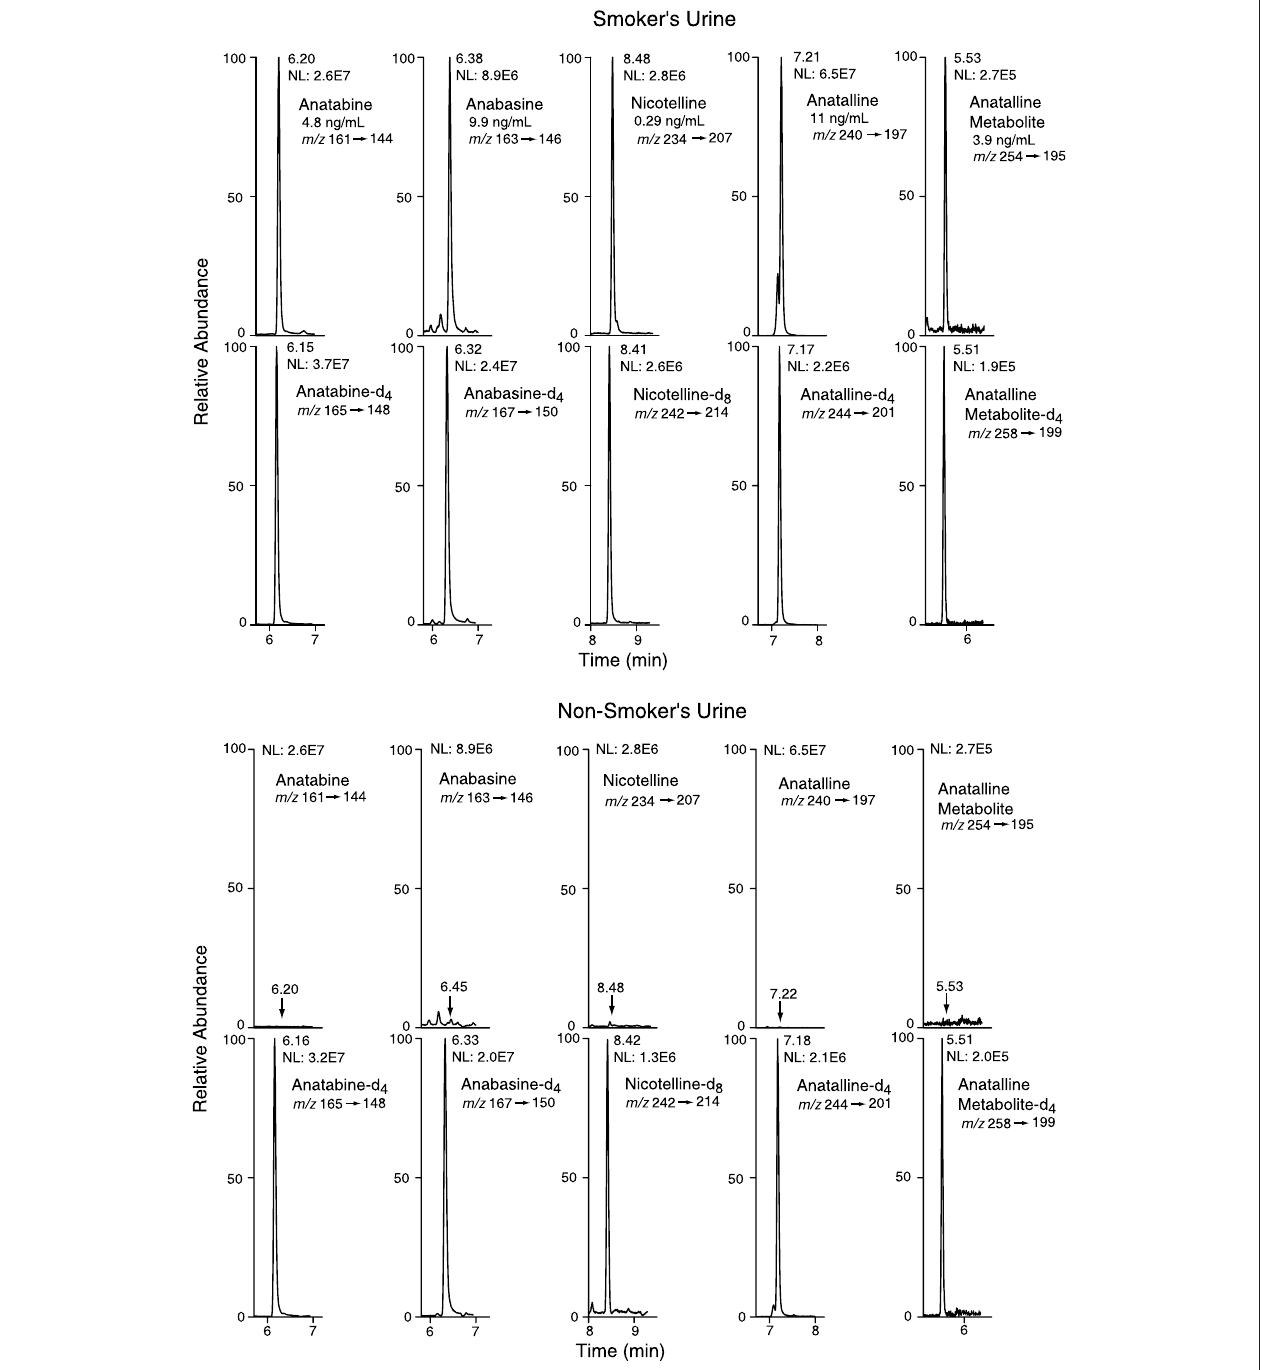
FIGURE5| Selectedreaction monitoring (SRM)chromatogramsfromurine analyzedbyMethod 1.Analytepeaks inthenon-smoker ’ schromatogram werescaled to match those of the smoker ’ s urine chromatogram. The internal standard concentrations were anabasine-d 4 and anatabine d 4 , 20 ng/ml; anatalline-d 4 , 0.8 ng/ml; anatalline metabolite-d 4 , 30 ng/ml; nicotelline-d 8 , 2 ng/ml.